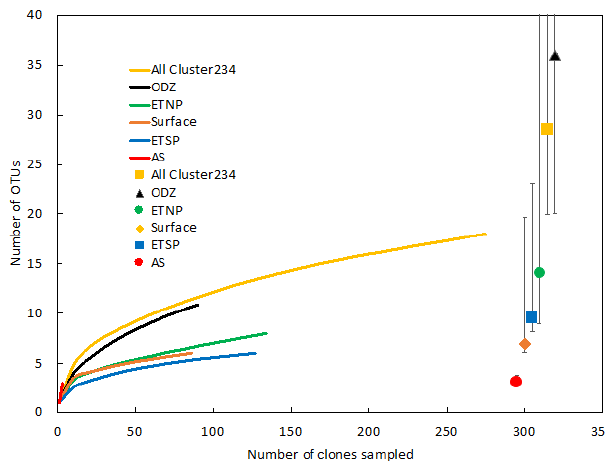
Figure 5. Rarefaction curve displaying observed OTU richness vs. the number of clones sequenced for Cluster II, III, and IV nifH se- quences (cDNA and DNA). OTUs were defined and designated as in Fig. 4. Chao estimators (individual symbols) are shown for each of the same subsets represented in the rarefaction